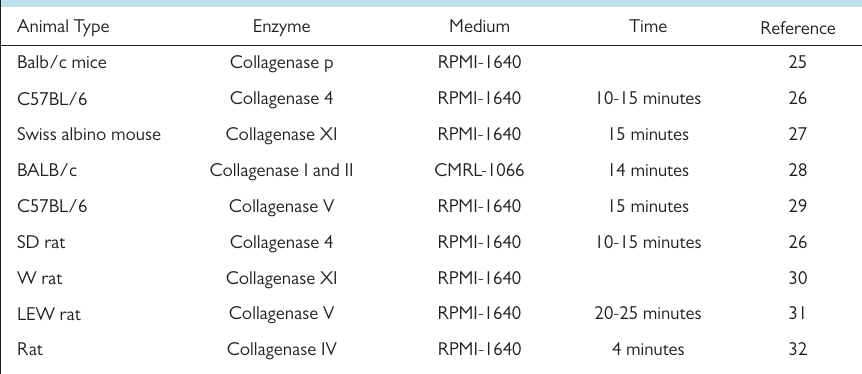
Table 1. Islet Isolation Procedure